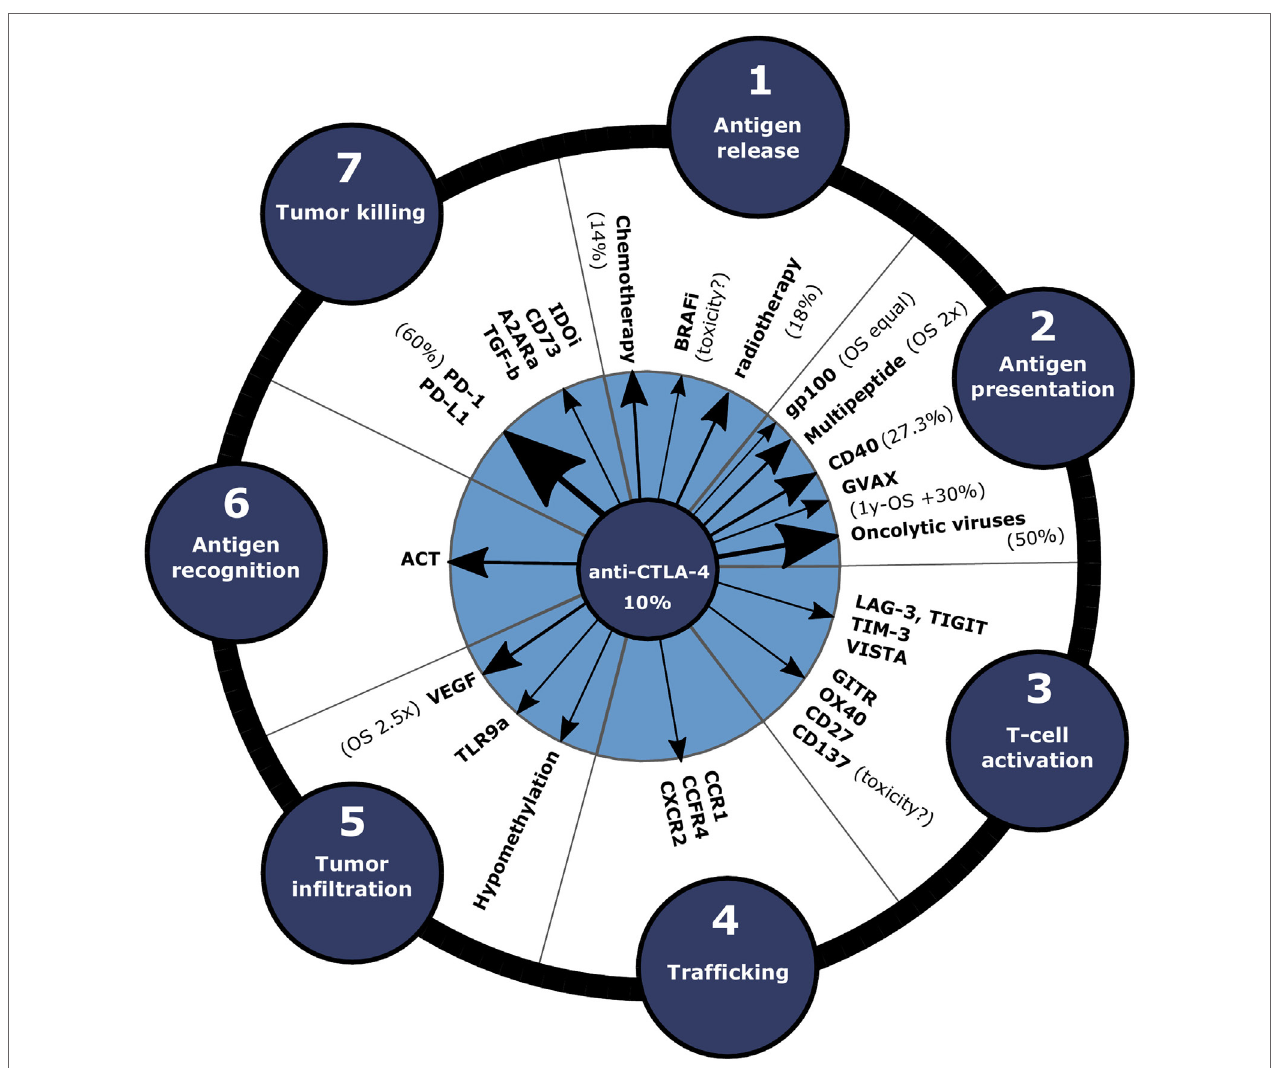
FigURe 1 | Clinical efficacy of combination approaches with anti-CTLA-4 depicted in the cancer-immunity cycle . In order to enhance the response rate of immune-checkpoint blockade, anti-CTLA-4 can be combined with therapies that promote various steps of the cancer-immunity cycle. Arrow size indicates the efficacy increase compared to anti-CTLA-4 monotherapy in clinical and preclinical studies. Clinical response rates or OS data compared to anti-CTLA-4 only for the treatment of melanoma patients are annotated between brackets. Abbreviations: A2ARa, adenosine 2a receptor antagonist; ACT, adoptive cell transfer; BRAFi, BRAF V600E inhibitors; GVAX, cellular vaccines consisting of irradiated GMCSF-producing tumor cells; IDOi, IDO inhibitor; MEKi, MEK inhibitors; OS, overall survival; TLR9a, TLR9